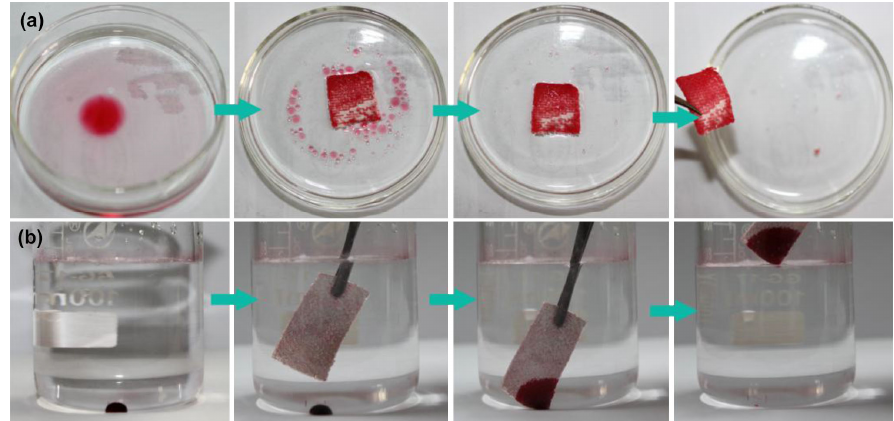
Figure 11. ( a ) Performance of removing oil floating on water and ( b ) heavy oil